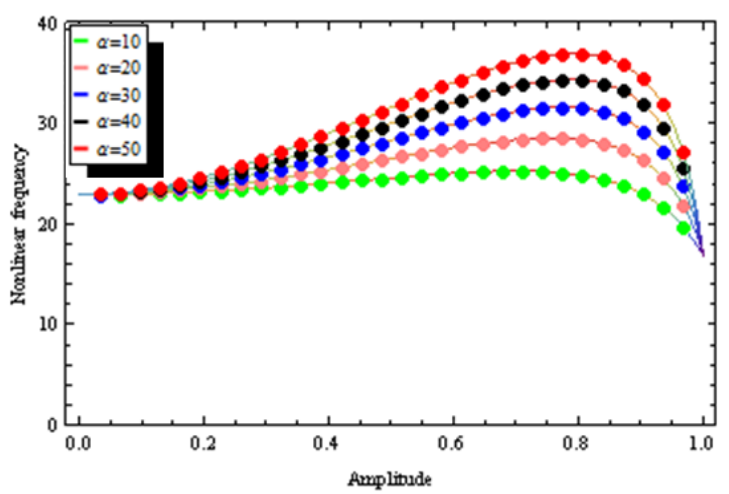
Figure 4. Effect of parameter V on nonlinear frequency of electrostatically actuated micro beam.